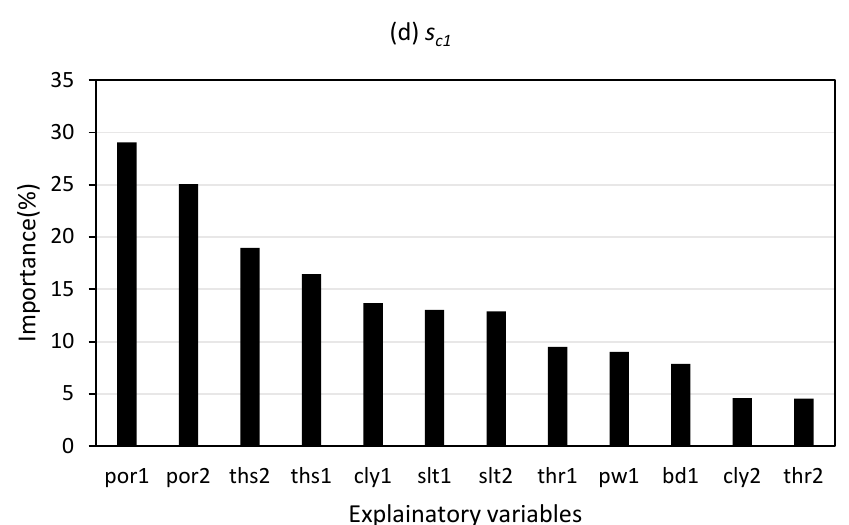
Figure 9. Relative importance (%) of soil, climatic and vegetation characteristics to ( a ) a , ( b ) b , ( c ) s w2 and ( d ) s c1 from the random forest model, sorted from largest to smallest. Suffix 1 represents the near-surface soil layer (0–5 cm), and suffix 2 represents the root-zone soil layer (5–100 cm).